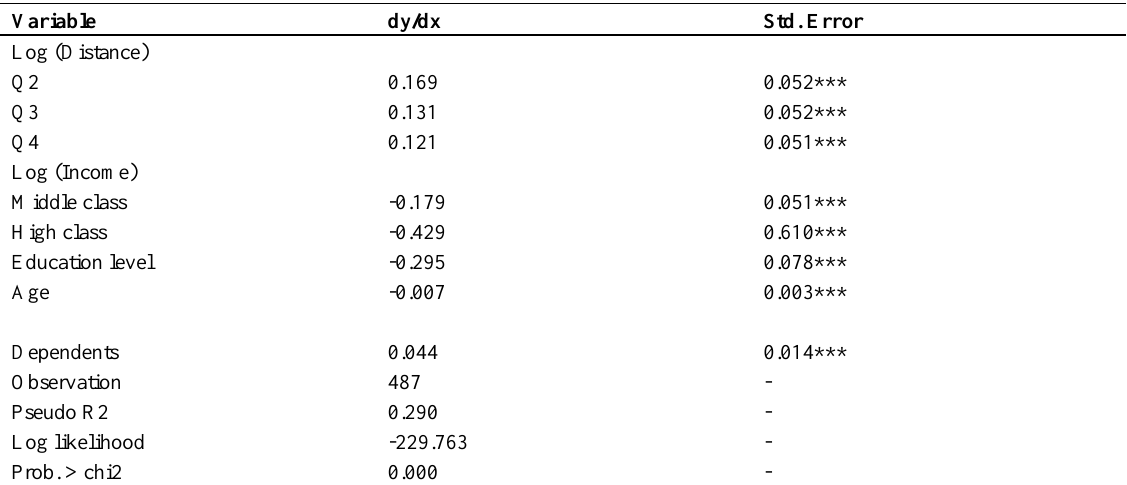
Table 4: Estimation of the choice of formal or informal